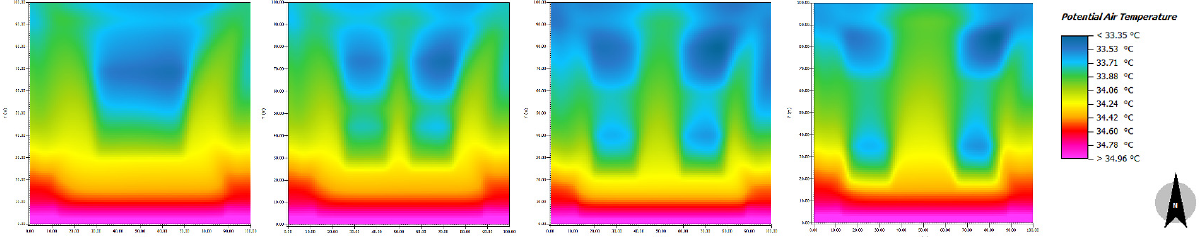
Figure 8. Distribution of temperature in cases 1, 2, 3, and 4 at